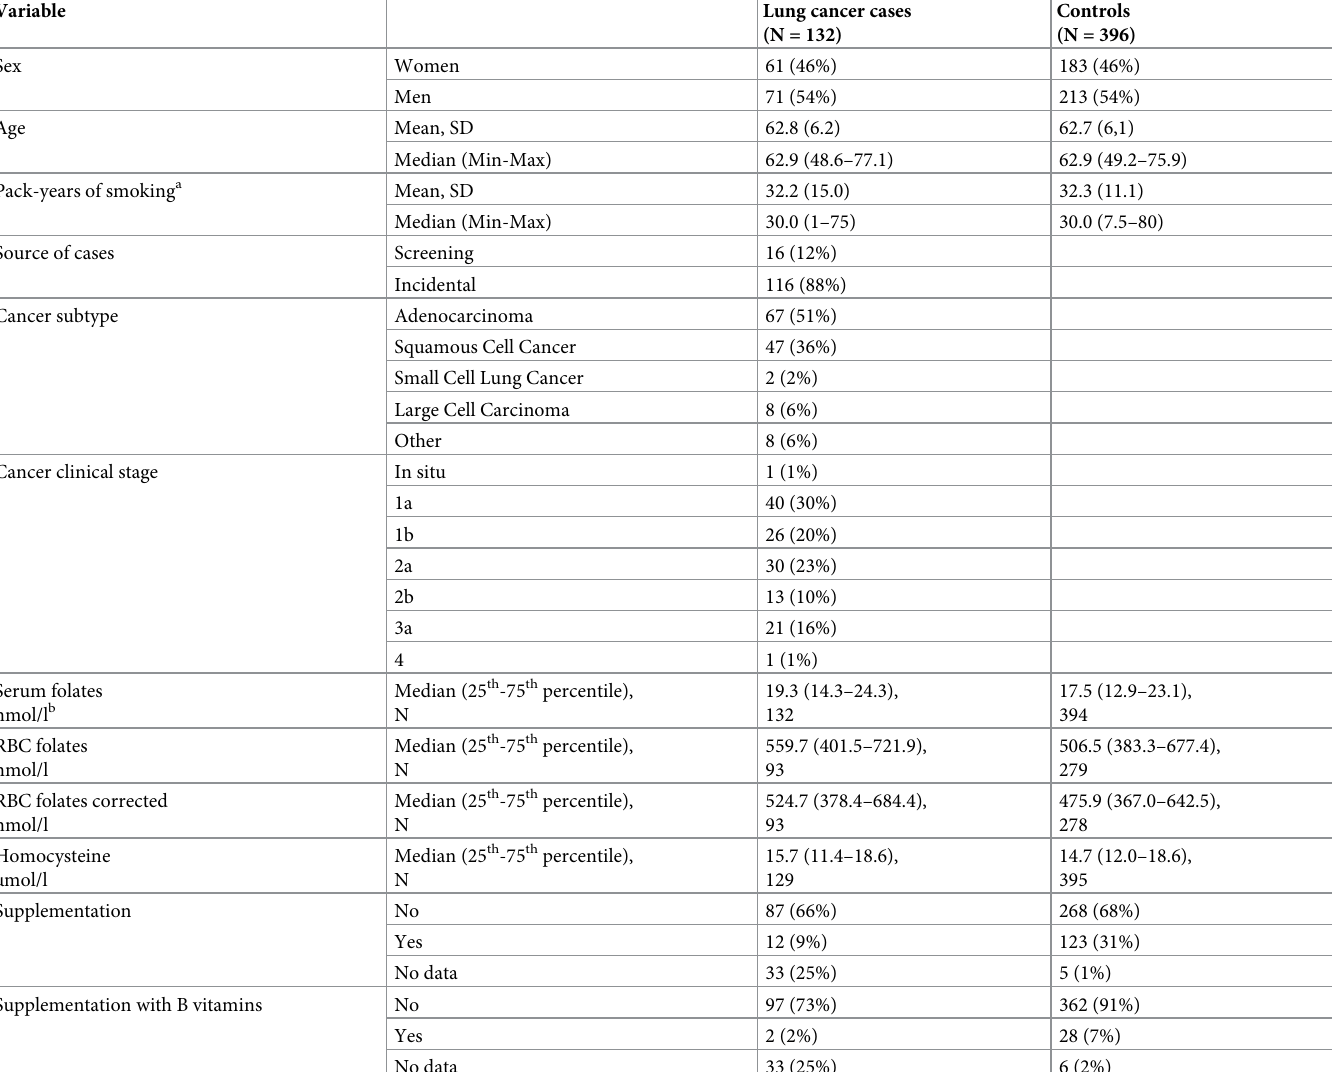
Table 1. Characteristics of participants in lung cancer case-control study population from northern